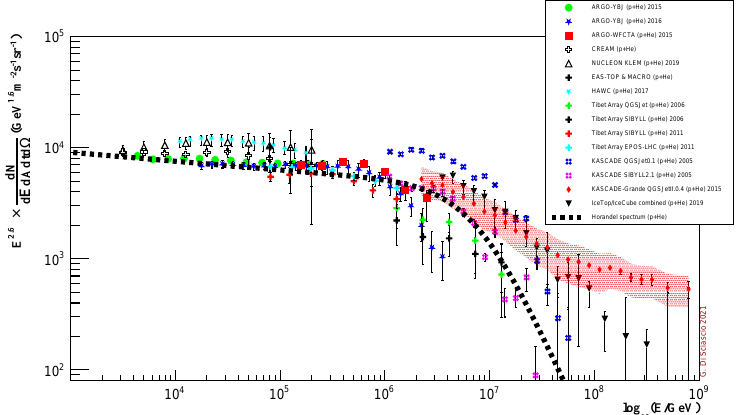
Figure 7. The energy spectra shown in Figure 6 compared with the results obtained by HAWC in the 10–100 TeV region [63] and by KASCADE–Grande [27] and IceTop/IceCube [29] combined above the PeV. The parametrization of the light component provided by Hörandel [62] is also